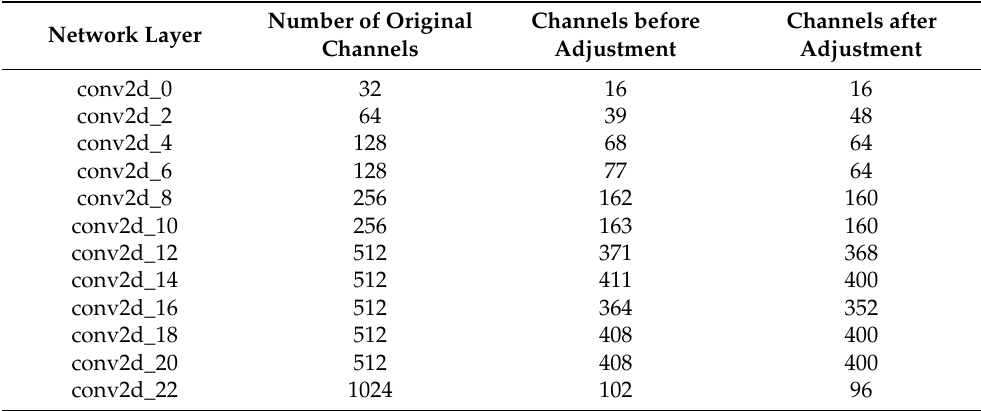
Figure 12. Sensitivitives of SSD-MobileNet-v1. Table 2. Number of channels in each stage of